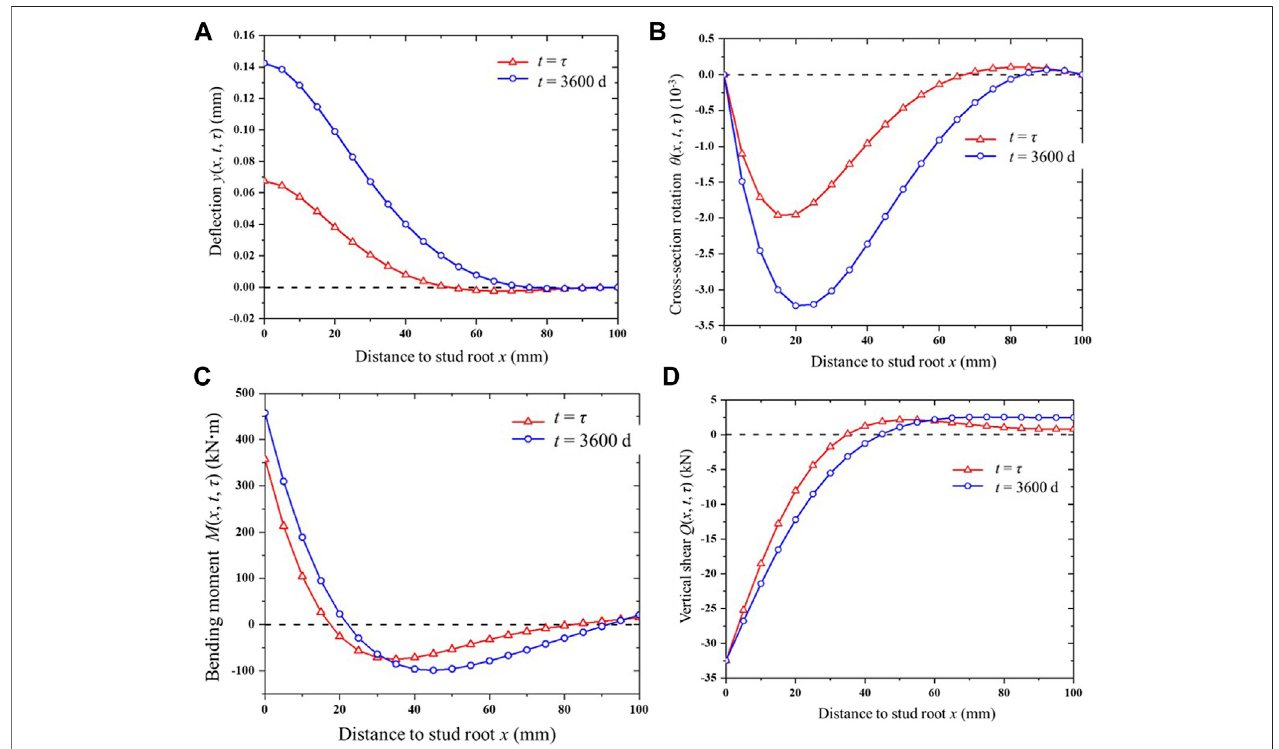
FIGURE 13 | Time-dependent response of the beam on elastic